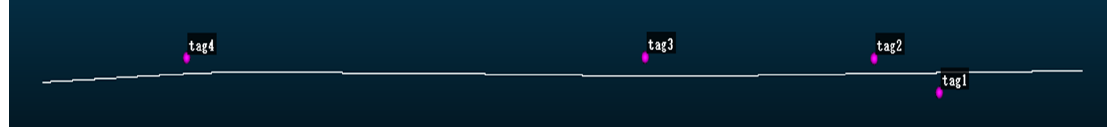
Figure 19. Overall distribution of the target.